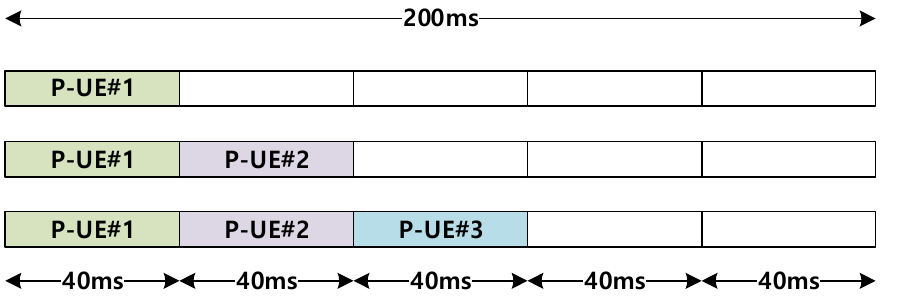
Figure 5. Aligning of partial sensing window for P-UEs.